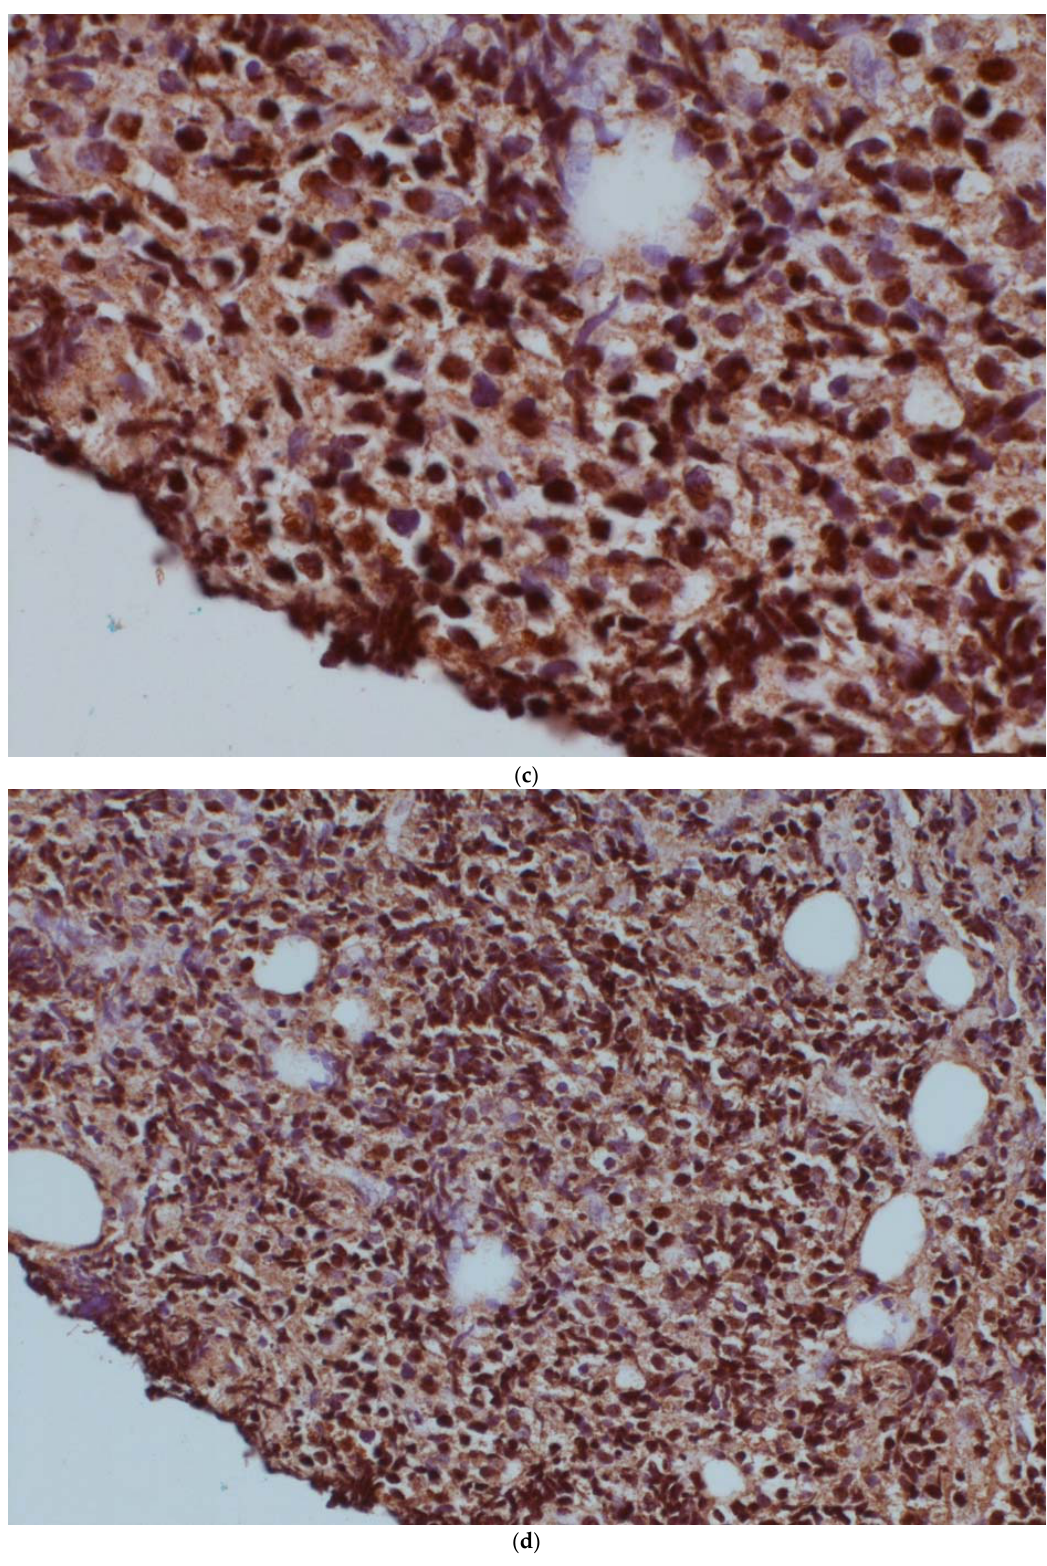
Figure 1. IRF8 expression in the pre-ibrutinib cutaneous lesion lacking t(14;16) ( a , b ), and post-ibrutinib nodal sample containing t(14;16) ( c , d ). Magnification times, ( a , c ) 100×, ( b , d ) 40×.